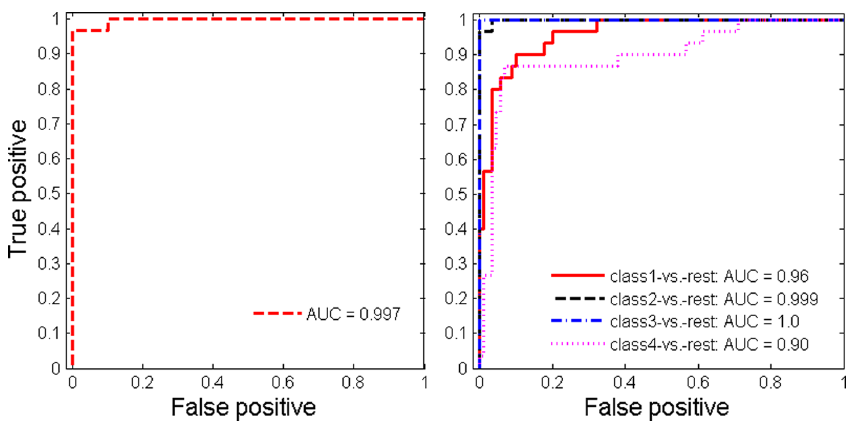
Figure 1. Test ROC curves and AUCs for simulation data: Left: 2-Classes; Right: 4-Classes.